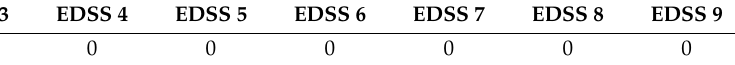
Table A1. Initial EDSS state distribution of the RRMS population entering the model. EDSS